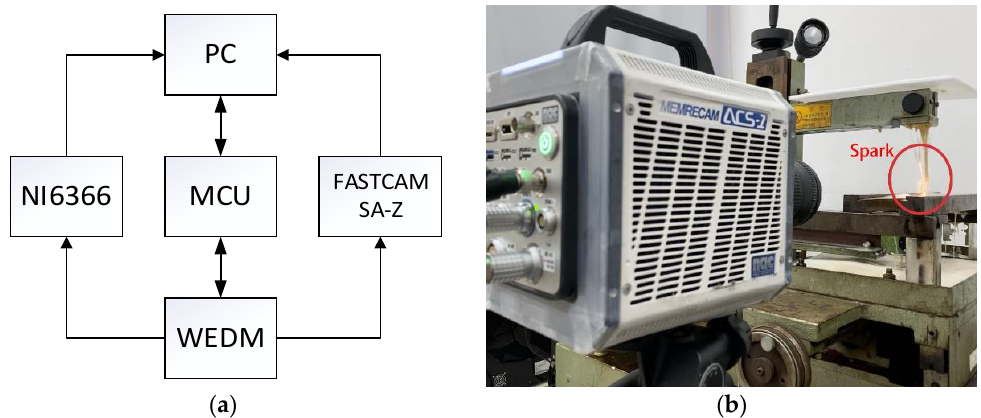
Figure 8. Experimental system: ( a ) control system; ( b ) experimental equipment.